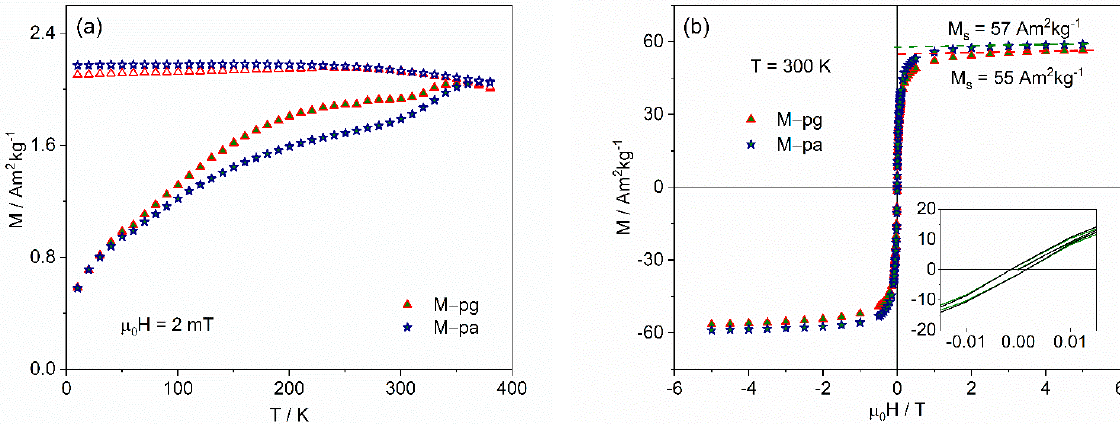
Figure 7. Magnetization results for the MNP synthesized with two additives: ( a ) temperature dependence after zero ‐ field cooling (ZFC) (full symbols) and after cooling under the measuring field of 2 mT (FC) (open symbols); ( b ) isothermal hysteresis curves at 300 K showing, in the inset, the zoomed low ‐ field region, confirming negligible coercivity.